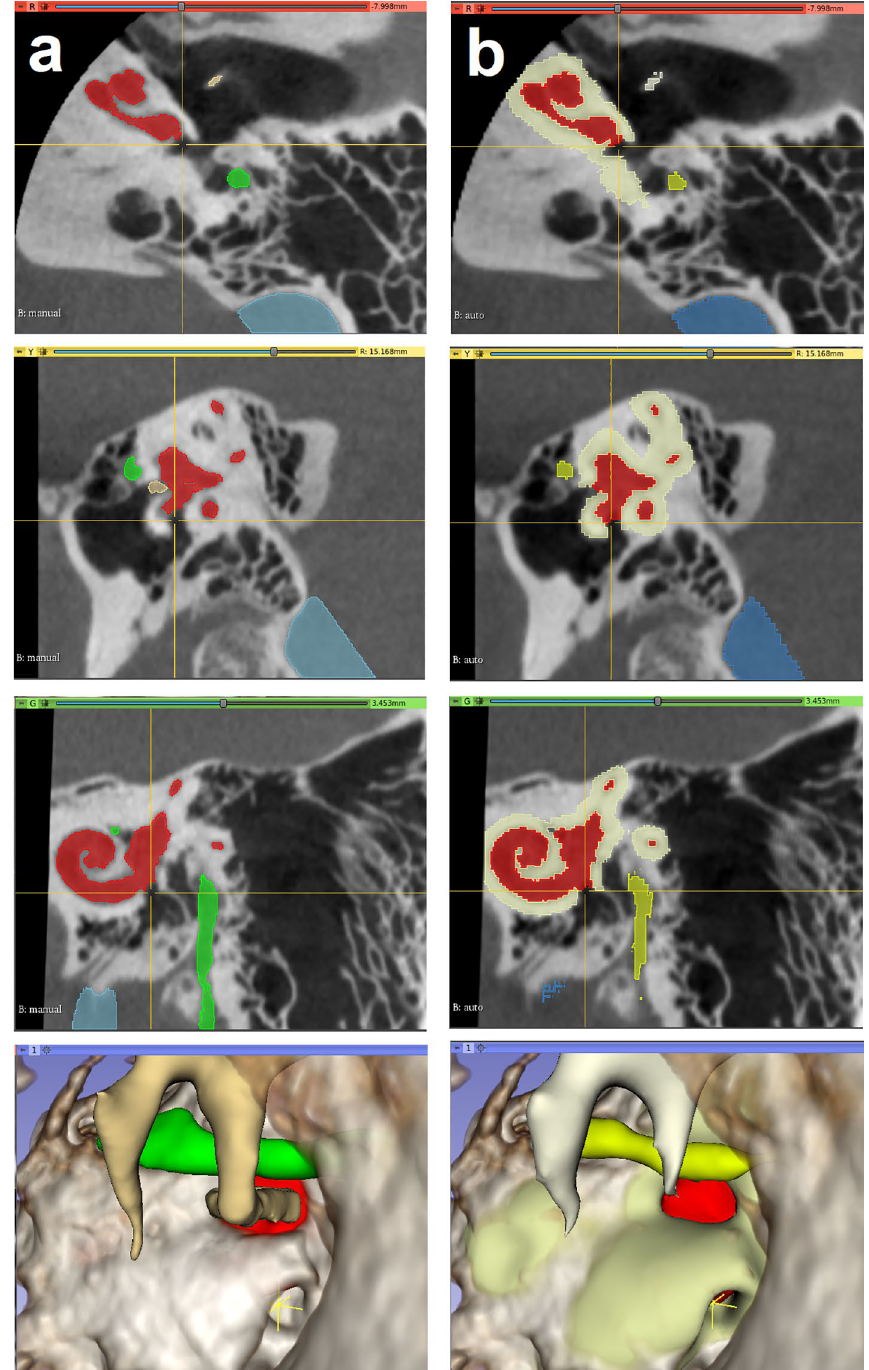
Figure 4. Round window niche (Crosshair) from a manual labeled scan (left— a ) side by side with the auto- segmented CT dataset (right— b ). From top to bottom, windows from 3D Slicer showing the axial, sagittal, coronal and 3D rendered view of the middle ear. Inner ear (red), ossicles (ivory); facial nerve (yellow), sigmoid sinus (blue) and otic capsule